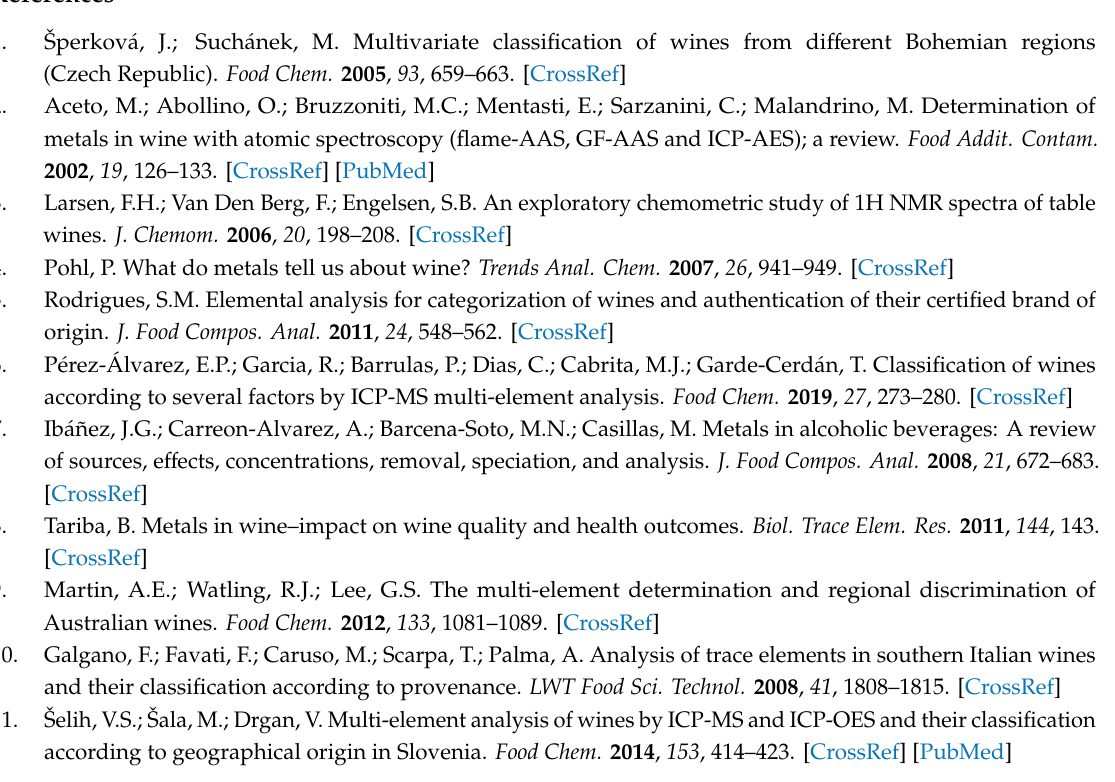
Supplementary Materials: The following are available online. Figure S1. Analytical recoveries with the hTISIS operated at 125 ºC and 30 µ L min − 1 for two real wine samples. Solid line indicates values of 100% for the recovery, whereas the dotted lines indicated 90% and 110% values. Spike concentration: 40 µ g kg − 1 ; Figure S2. Principal components analysis performed on data expressed as concentration of elements in wines from di ff erent designations of origin. (a) Loading plot; (b) score plot. Elements: Ba, Co, Cr, Mn, Ni, Pb and V; Figure S3. Map of Spain showing locations of the Protected Designation of Origin (PDO) wines evaluated on this study. PDO: (a) Alicante; (b) Bullas; (c) Campo de Borja; (d) Jumilla; (e) Castilla la Mancha; (f) Ribeiro; (g) Ribera del Duero; (h) Rioja; (i) Rueda; (j) Utiel-Requena; (k) Valdepeñas; (l) Valencia; Table S1. Rare earth elements concentration ( µ g kg − 1 ) in Rioja wine samples (mean ± 95%-confidence interval); Table S2. Rare earth elements concentration ( µ g kg − 1 ) in Alicante wine samples (mean ± 95%-confidence interval); Table S3. Rare earth elements concentration ( µ g kg − 1 ) in Bullas wine samples (mean ± 95%-confidence interval); Table S4. Rare earth elements concentration ( µ g kg − 1 ) in Campo de Borja wine samples (mean ± 95%-confidence interval); Table S5. Rare earth elements concentration ( µ g kg − 1 ) in Jumilla wine samples (mean ± 95%-confidence interval); Table S6. Rare earth elements concentration ( µ g kg − 1 ) in Castilla la Mancha wine samples (mean ± 95%-confidence interval); Table S7. Rare earth elements concentration ( µ g kg − 1 ) in Ribeiro wine samples (mean ± 95%-confidence interval); Table S8. Rare earth elements concentration ( µ g kg − 1 ) in Ribera del Duero wine samples (mean ± 95%-confidence interval); Table S9. Rare earth elements concentration ( µ g kg − 1 ) in Rueda wine samples (mean ± 95%-confidence interval); Table S10. Rare earth elements concentration ( µ g kg − 1 ) in Utiel-Requena wine samples (mean ± 95%-confidence interval); Table S11. Rare earth elements concentration ( µ g kg − 1 ) in Valdepeñas wine samples (mean ± 95%-confidence interval); Table S12. Rare earth elements concentration ( µ g kg − 1 ) in Valencia wine samples (mean ± 95%-confidence interval); Table S13. Spanish commercial wines with their provenance, sample codification, vintage, color, grape variety and aging.; Table S14. Analysis of variance of the rare earth elements content in Spanish commercial wines (n = 50, F (95%) = 2.31); Table S15. ICP-MS operating